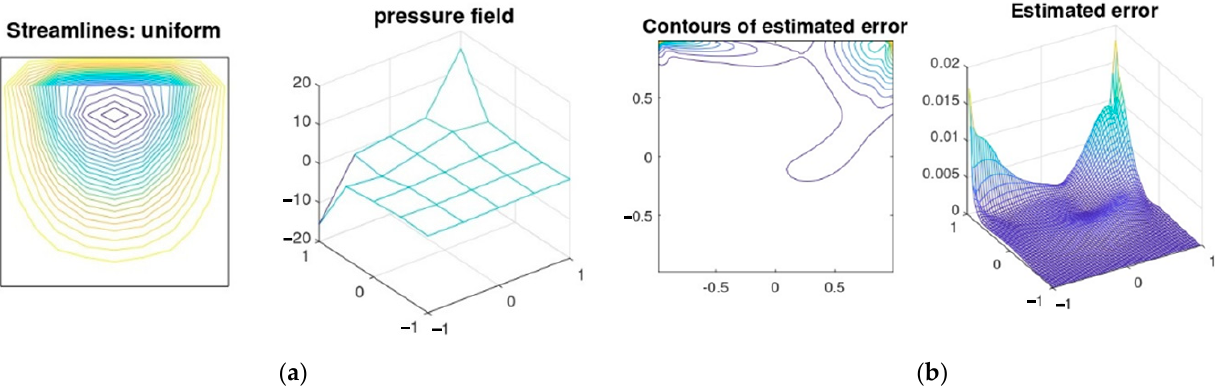
Figure 6. Error associated with a 16 × 16 and a 256 × 256 square grid, Q 1 – Q 1 approximation. ( a ) 16 × 16 elements; ( b ) 256 × 256 elements.